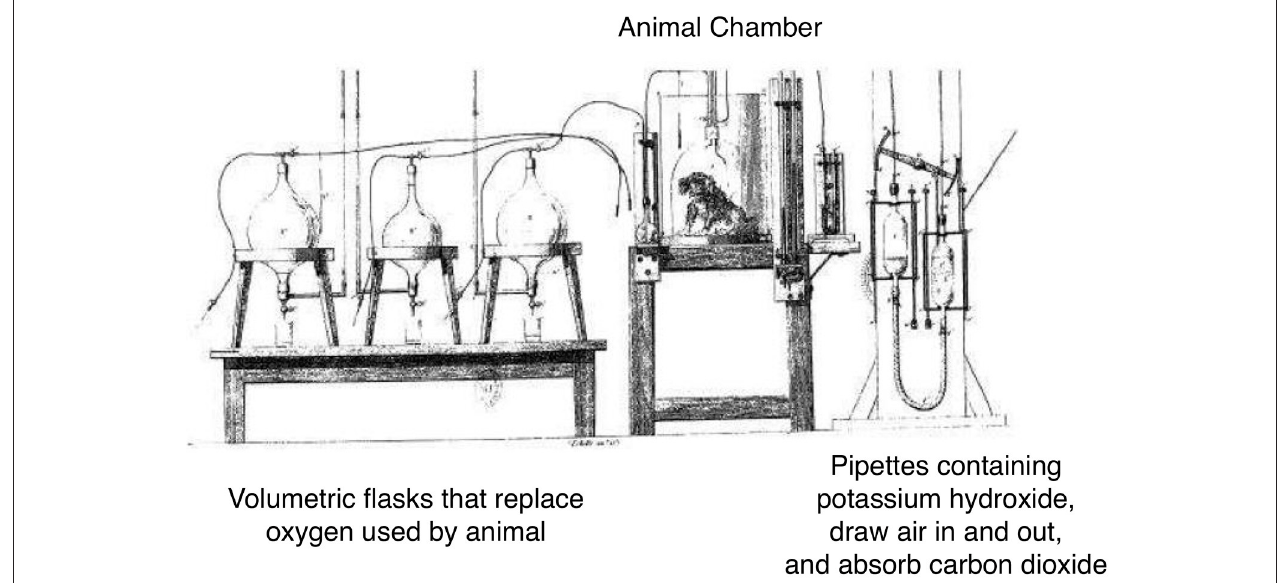
FIGURE 2 | The apparatus of Henri Victor Regnault and Jules Reiset (1849). Adapted from Regnault and Reiset. In this closed loop device, oxygen was supplied to the dog by a tube on the left and carbon dioxide was removed by the tubes on the right. Oxygen was delivered as required to replace that used up by the animal, therefore oxygen consumption was measured by the amount required to maintain constant system pressure. Carbon dioxide was removed by an absorbent and then returned to the respiration chamber to be used over again. Weighing of the absorption vessels allowed measurement of carbon dioxide